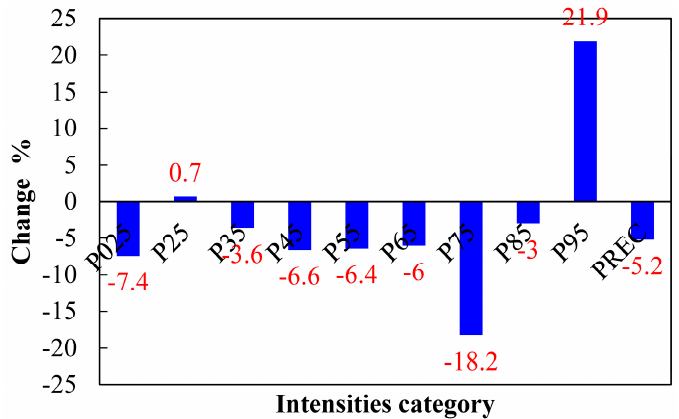
Figure 5. Median changes (%) of precipitation amount for nine precipitation intensities among 29 stations during the period of 1959–2013.